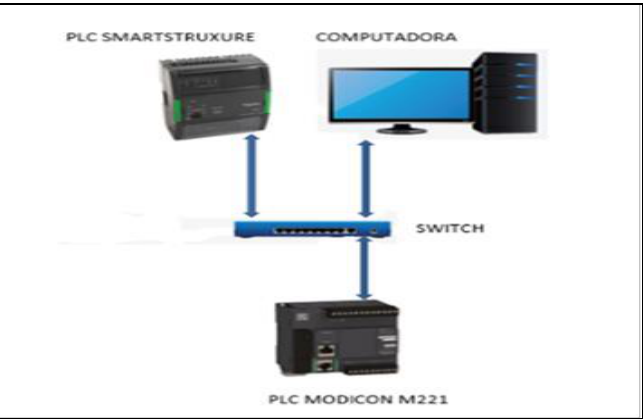
Figura 7: Conexión de los PLC al SCADA. Fuente: Los autores, (2018).